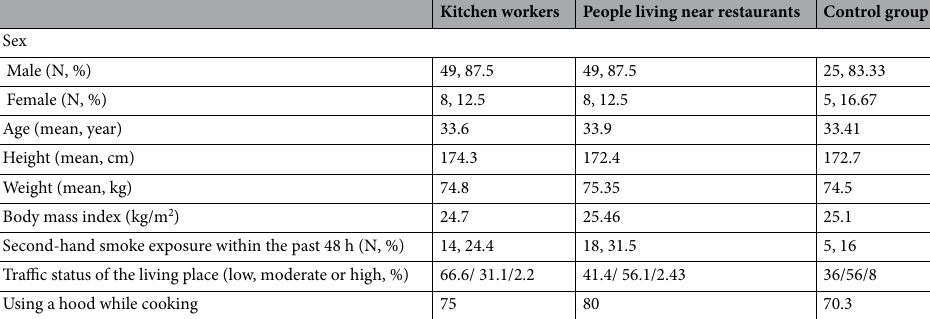
Table 1. Specifications of the studied groups in terms of